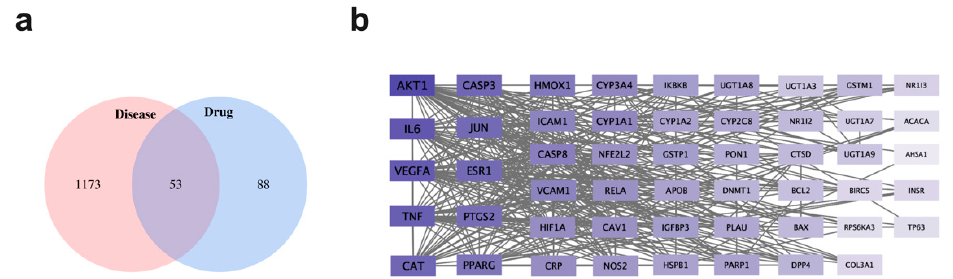
Figure 1. The targets related to polyphenols in blueberry leaves (PBL) in the treatment of non-alcoholic fatty liver disease (NAFLD). ( a ) Distribution of PBL potential targets and NAFLD targets. ( b ) Protein–protein interaction (PPI) networks of PBL for the treatment of NAFLD. The importance of targets depends on the shade of purple and the grey line represents the interaction relationship.